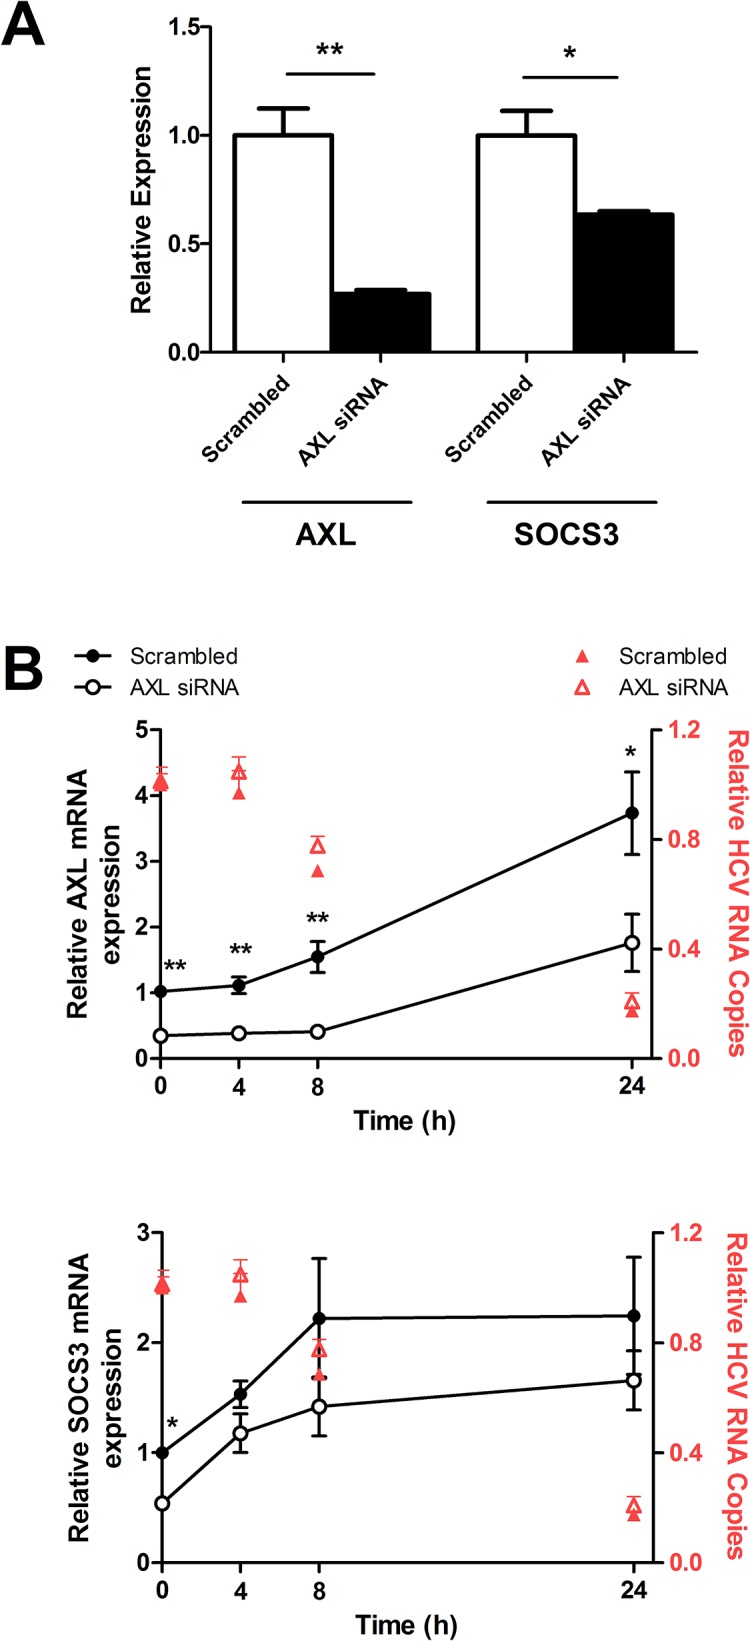
AXL knockdown reduces SOCS3 expression but does not affect HCV replication.
AXL specific siRNA knockdown reduced AXL expression by approximately 75%, also resulting in a significant reduction of SOCS3 by approximately 40% (A). AXL knockdown was maintained for 24 h after 50 U/ml IFNα stimulation, with a non-significant trend towards reduced SOCS3 expression (B). AXL knockdown did not reduce HCV viral replication following IFNα treatment (red triangles) (* p<0.05, ** p<0.01). Data represents the mean and standard error of two biological replicates performed in duplicate.